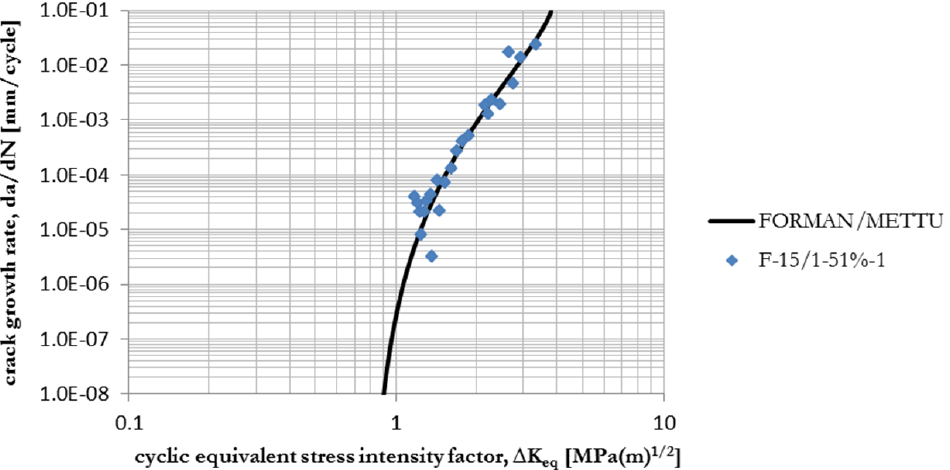
Figure 9: Fatigue crack growth rate data for compact tension specimen (0° fibre direction, R =